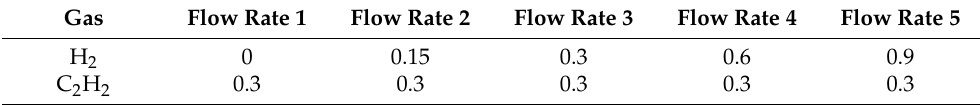
Table 1. Different gas compositions in the growth atmosphere (The unit of flow rate is L/min).